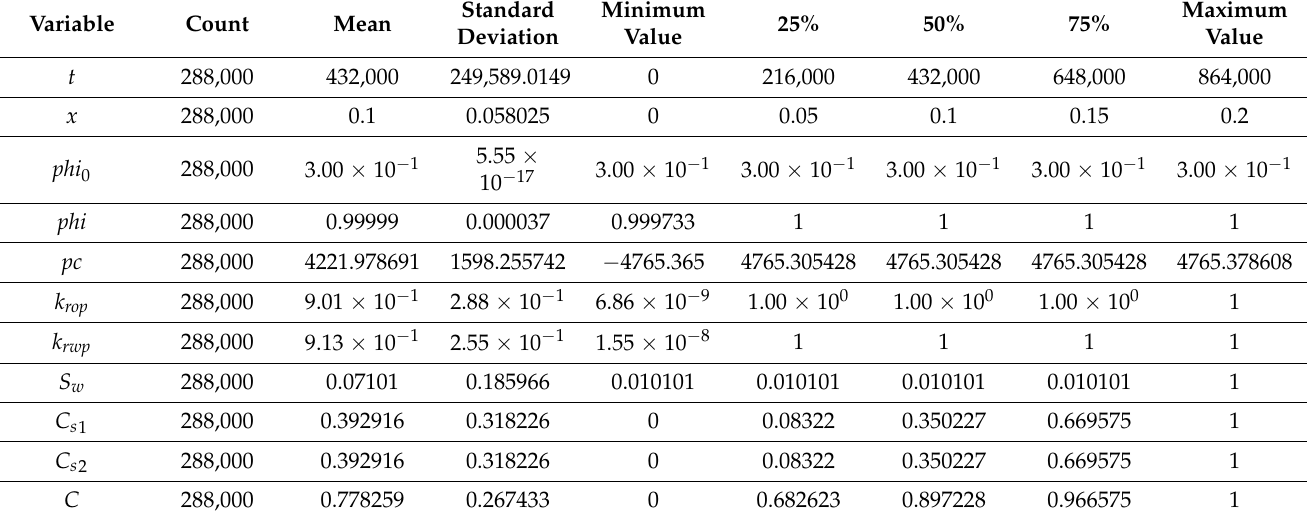
Table 2. The statistical information of some of the dataset